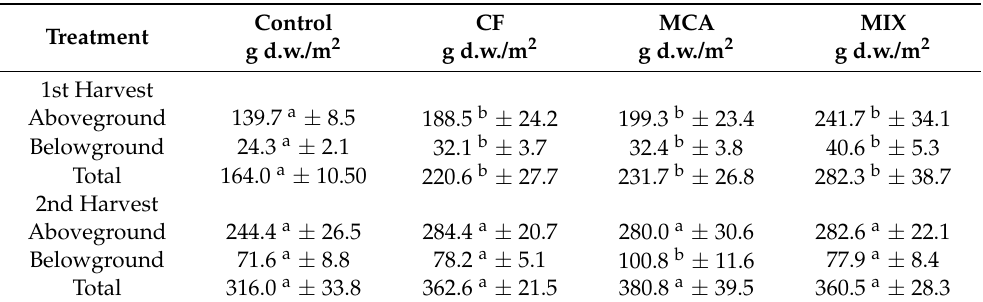
Table 2. Aboveground, belowground, and total plant biomass (gram of dry weight per square meter ± one standard deviation, n = 4), sampled at the end of each growth cycle in control and treated plots.